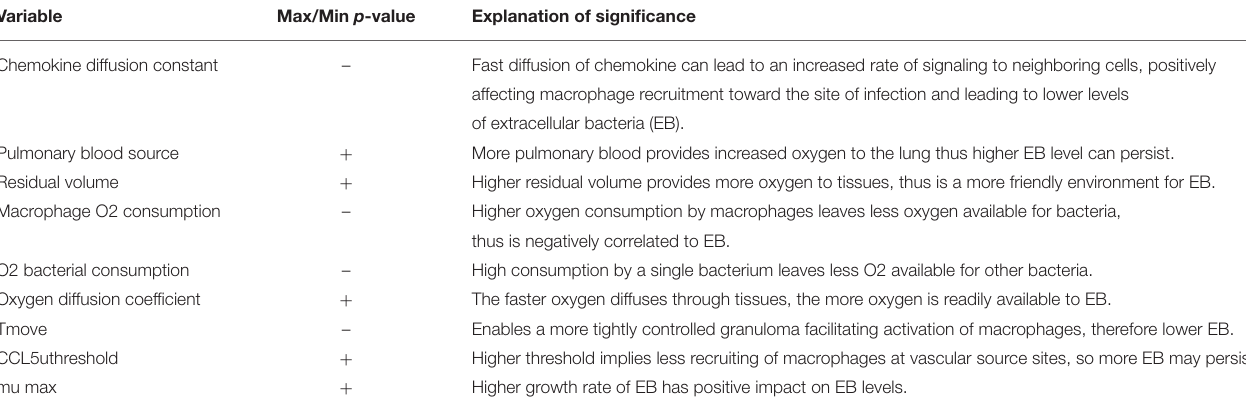
TABLE 6 | Significant Partial Rank Correlation Coefficients for the integrated multiscale model of oxygen-modulated host response to Mtb infection. Variable